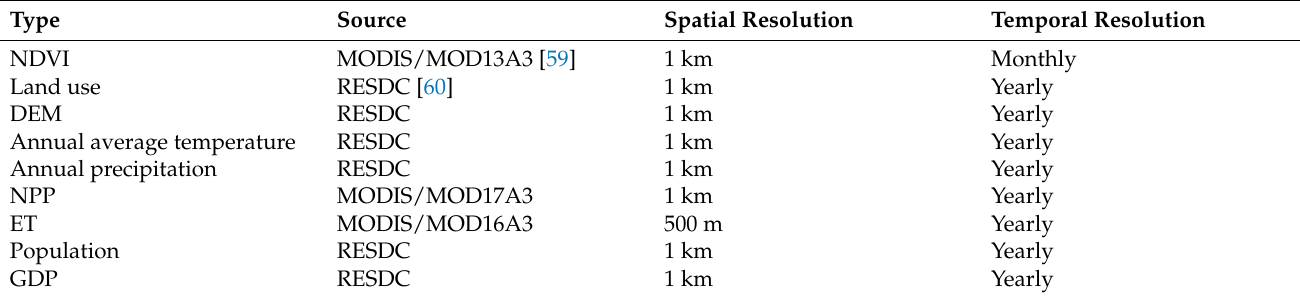
Table 3. Basic data and sources of ecological vulnerability assessment for the Qinghai-Tibet